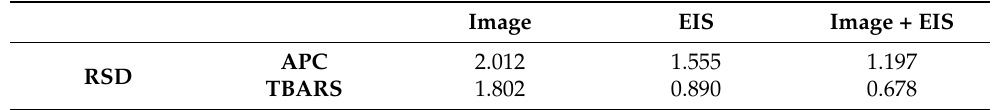
Table 5. Comparison of APC/TBARS value prediction RSD among image input only, EIS information only, and image input with EIS information.